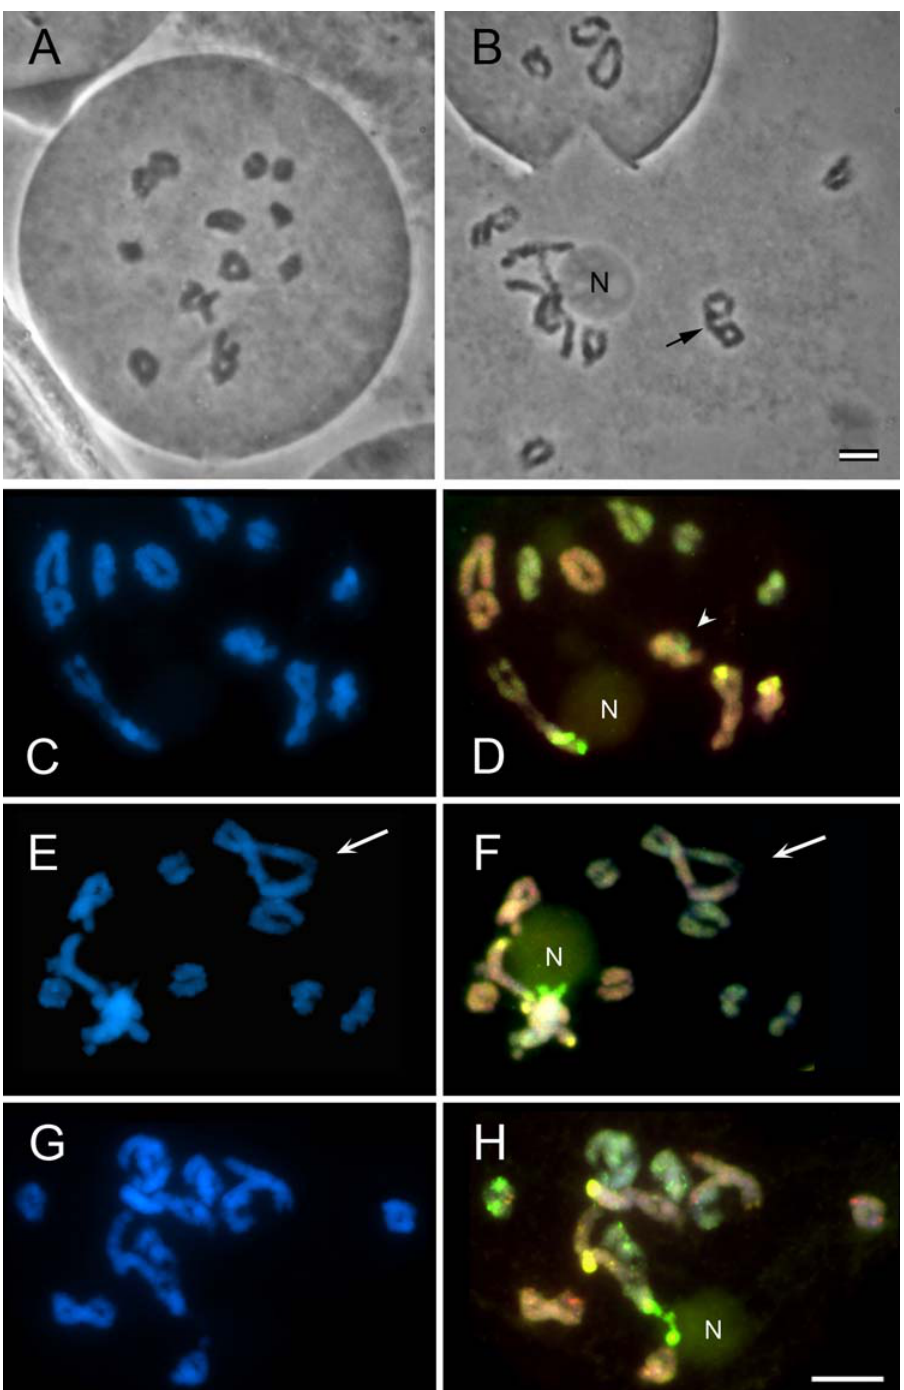
Figure 4. Pollen meiosis in synthetic T.mirus. (A,B) Feulgen staining showing in (A) 12 regular bivalents and (B) one quadrivalent (arrow) and bivalents in close association with each other and a nucleolus. (C–H). Fluorochrome colours and GISH probes are as in Figure 2. (C–D) Note chromosome A du in association with the nucleolus. Two bivalents, one from the T. dubius genome (yellow) and one from the T. porrifolius genome (orange), overlapped (arrow), perhaps occurring as a multivalent. (E–F). Note the rDNA and the bivalents carrying these genes associated with the nucleolus. A quadrivalent with two chromosomes of T. dubius origin and two of T. porrifolius origin occurring in a ring (arrow). (G–H) Note two bivalents (A du and D po ) with rDNA associated with the nucleolus and the A po bivalent with condensed rDNA unassociated with the nucleolus. N=nucleolus. Scale bar (C–H) is 10 m m.